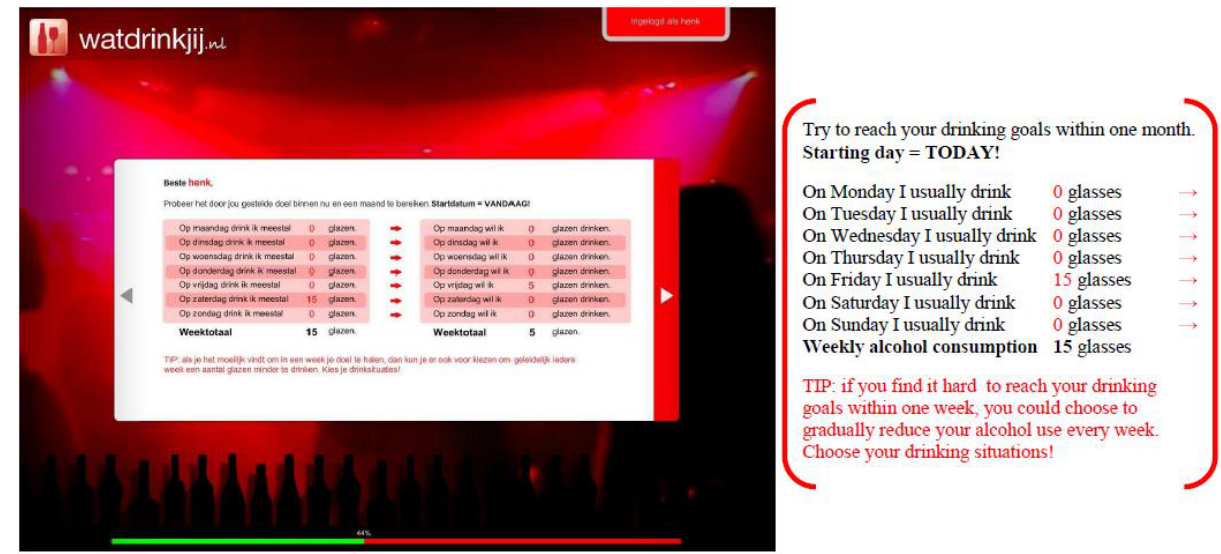
Figure 3. Screenshot and English translation of drinking goals on the What Do You Drink website.